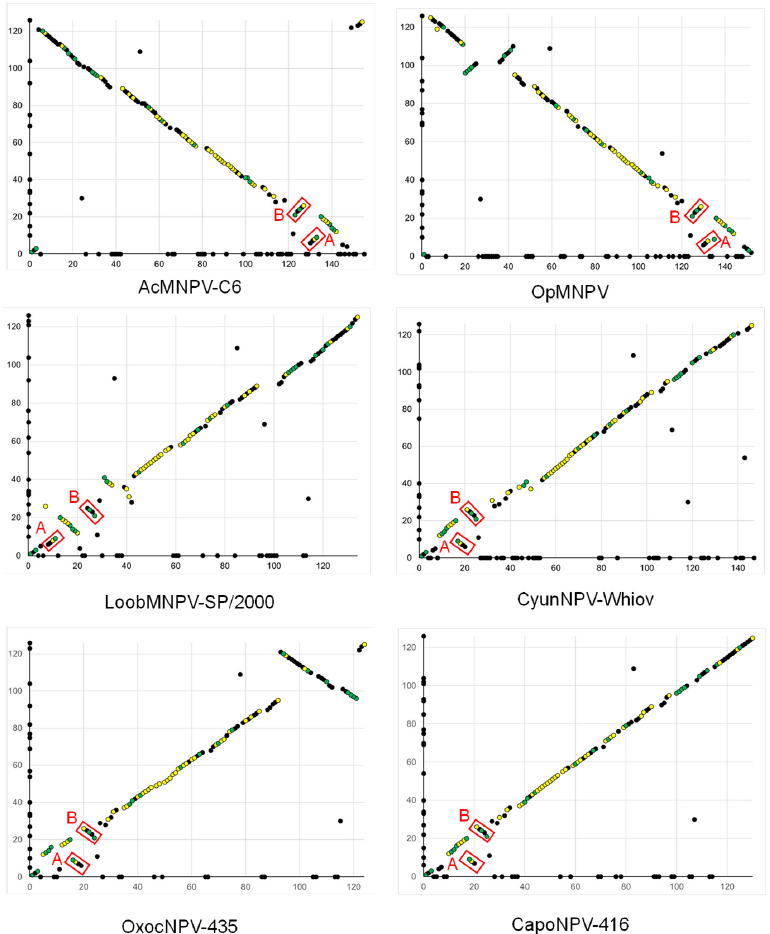
Figure 4. Gene-parity plots comparing the ORF content and order of PastNPV-473 ( y -axis) with six other group I alphabaculviruses ( x -axis). Points correspond to individual ORFs. ORFs occurring only in one of the two genomes being compared are plotted directly on the axis corresponding to the virus containing the ORF. Points are color-coded to indicate baculovirus core genes (yellow) and genes conserved among Alphabaculovirus genomes (green). Two clusters of ORFs that are inverted in PastNPV-473 relative to ORFs of the other viruses in the plots are indicated by red boxes (A and